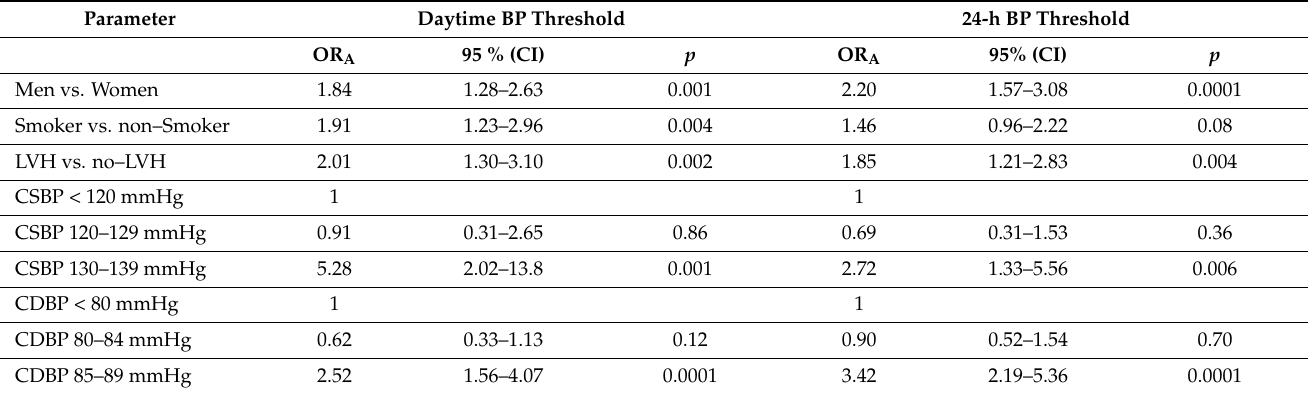
Table 4. Predictors of MUCH by specific thresholds in multivariate analysis.